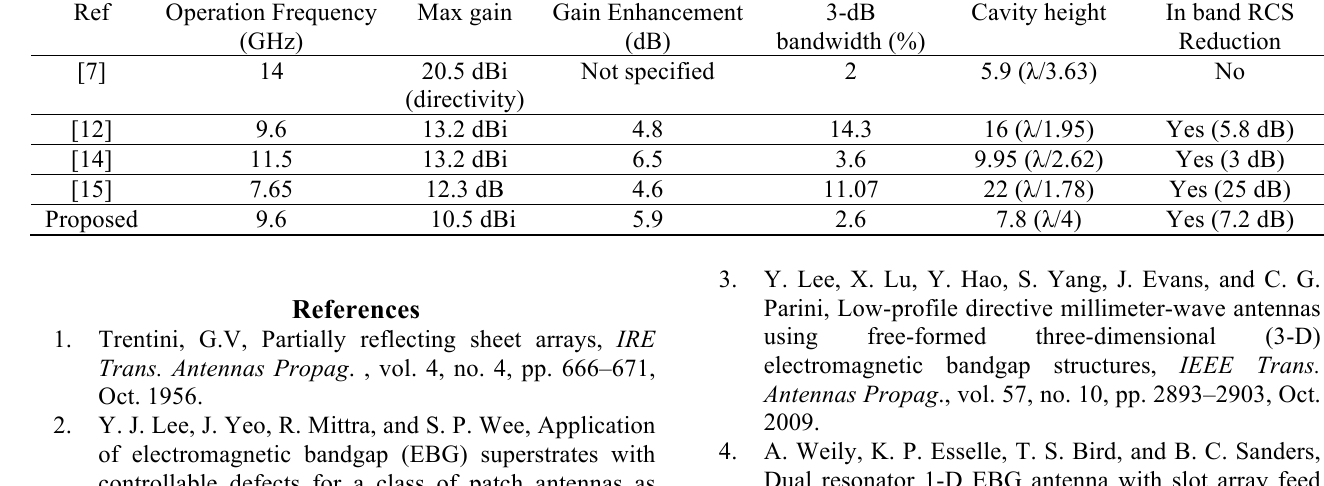
Table I: Comparison with other cavity antennas